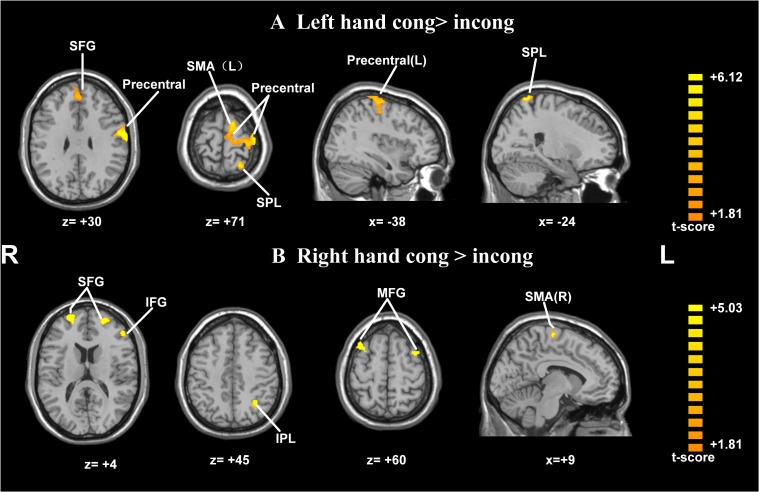
Statistically different t-maps between the congruent and incongruent drawings during left- or right-hand flexed conditions. (A, left forearm flexed: congruent > incongruent, left hand cong > incong; B, right forearm flexed: congruent > incongruent, right hand cong > incong) (paired t-test, p < 0.05, corrected). t-score bars are shown on the right. The numbers beneath the images refer to the MNI coordinates.